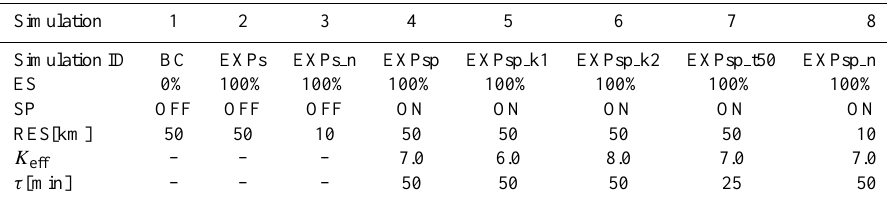
Fig. 3. Vertical cross-section along latitude 45.2 ◦ N of average absolute (top) and relative (bottom) NO x contribution in pptv and %, respectively, to the total NO x by introducing ship emissions for winter (left) and summer (right) season as the difference of experiments EXPs and BC with approximate altitudes. Table 2. Summary of runs carried out by the RegCM/CAMx model pair coupled offline. ES stands for ship emissions, SP for ship plume parameterization, RES means the grid spacing in km (same in x/y direction), K eff is the effective reaction rate in 10 − 19 molecules − 1 s − 1 cm 3 and τ denotes the dilution time in